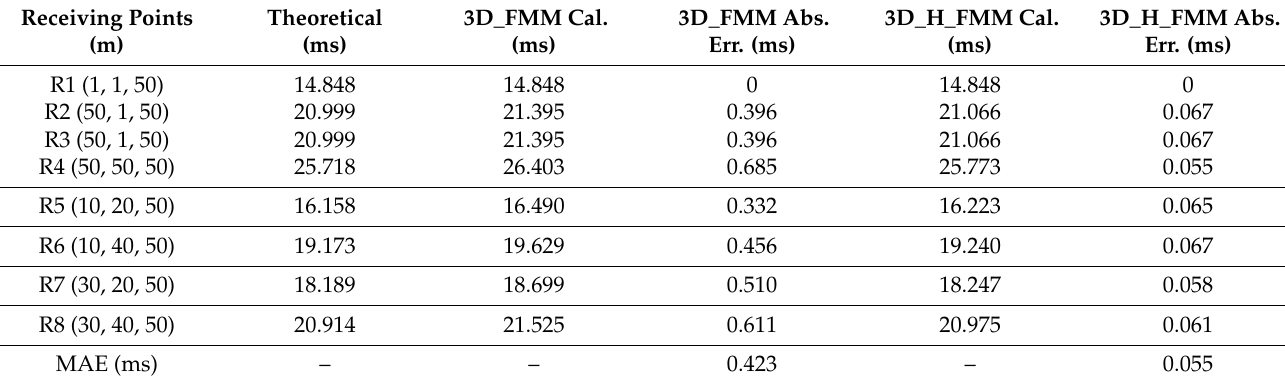
Table 3. The travel time and its absolute error at the receiving points of R1 to R8 calculated by 3D_H_FMM and 3D_FMM in the Case A: small-scaled homogeneous model.